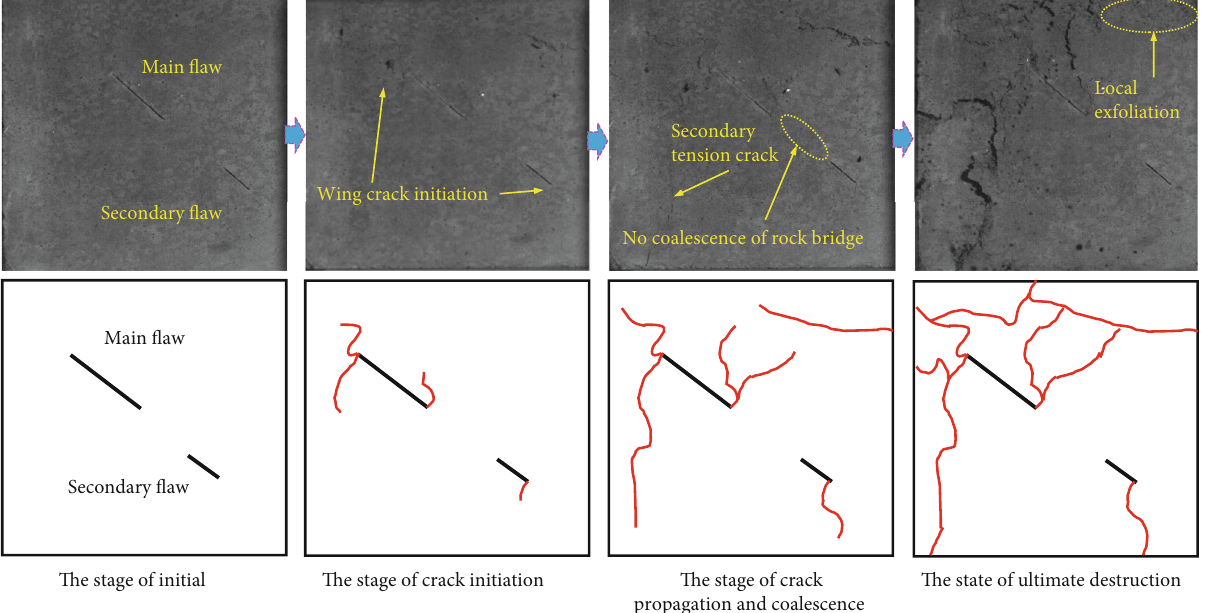
= 24mm , 2 l = 12mm , 2 d = 24mm 1 2